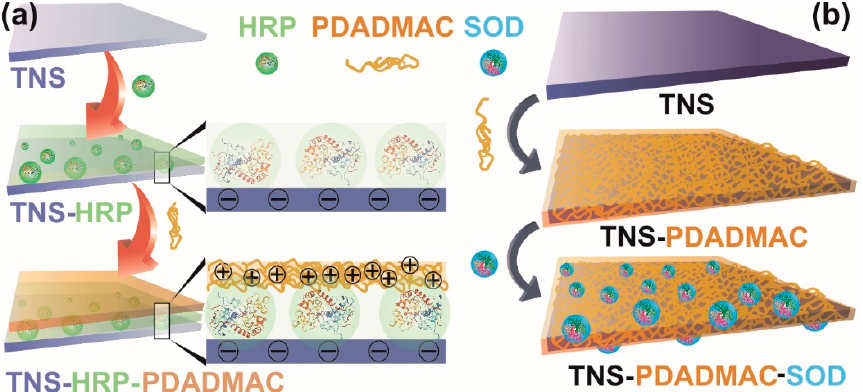
Figure 5. Illustration of HRP ( a ) and SOD ( b ) immobilization on titania nanosheet (TNS) of saturated poly(diallyldimethylammonium chloride (PDADMAC) polyelectrolyte layer on the surface. Reprinted with permission from (Rouster, P.; Pavlovic, M.; Saringer, S.; Szilagyi, I.